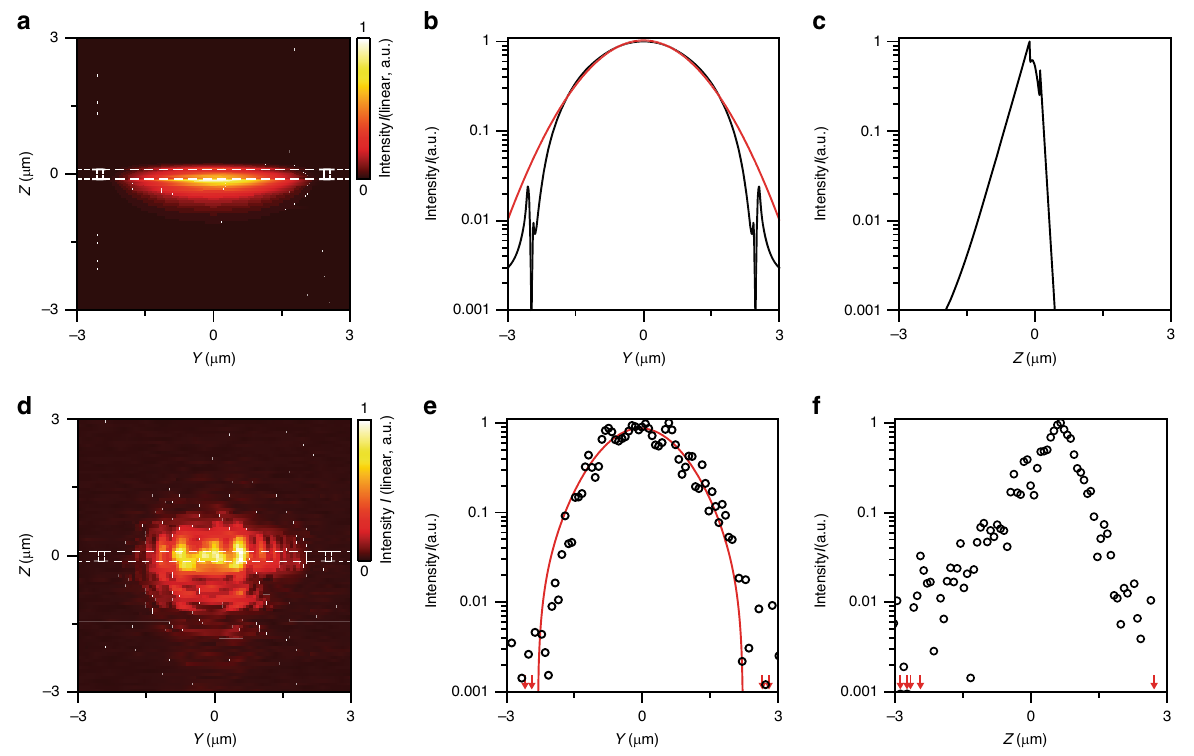
Fig. 3 Waveguide mode cross-section. a 3D FDTD simulation obtained under multimode excitation of the waveguide. b Mode cross-section of ( a ) at Z = 0, where the black line is the simulated data and the red line is a Gaussian fi t (FWHM = 2.9 µm). c Mode cross-section of ( a ) at Y = 0, where the black line is the simulated data. d Experimental far- fi eld image of guided light emitted from a cleaved waveguide facet. e Cross-section of ( d ) at Z = 0, where the black circles are the measured data and the red line is a Gaussian fi t (FWHM = 1.9 µm). f Cross-section of ( d ) at Y = 0, where the black circles are the measured data. Red arrows in ( e , f ) indicate data points outside the plot window. White dashed lines in ( a , d ) show the outline of the waveguide structure as de fi ned in Fig.